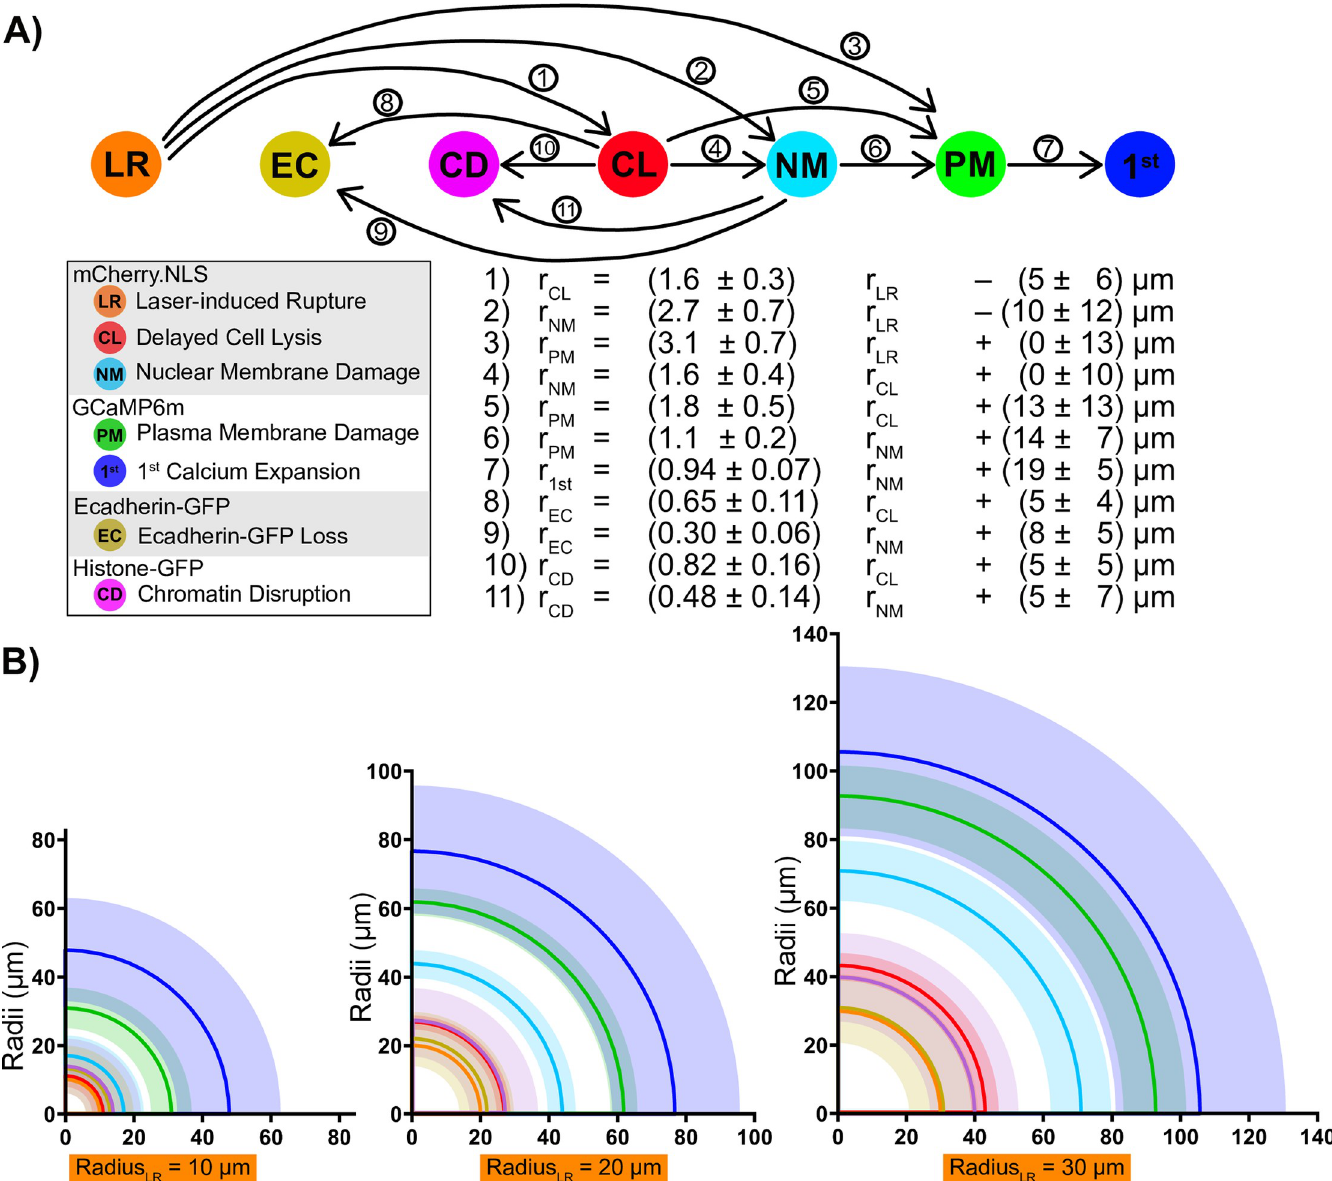
Fig 6. Each zone of damage can be estimated given one of them. (A) Schematic of how to calculate each zone of damage value from a given one, with each of the eleven linear equations displayed below corresponding to the arrows above. Arrows go from independent variable (x) to dependent variable (y), corresponding to Eqs 1–11 derived in Figs 2–5. The complete set of 42 equations necessary to relate each of the 7 zones of damage were derived according to the Materials and Methods and are provided in S2 Dataset. (B) Three hypothetical wounds are indicated, each with a different initial laser-induced rupture radius (10, 20, or 30 μ m). The equations in S2 Dataset were used to derive the radii of the six other zones of damage from the given laser-induced rupture radius. The 95% confidence intervals are displayed for all values. With a radius of 10 μ m, the first four regions overlap (laser-induced rupture, immediate Ecadherin loss, chromatin disruption, delayed cell lysis). Because the average cell diameter in this tissue is ~7 μ m, the overlap suggests that these four regions may be within one cell diameter. As the wound gets larger, the regions become more